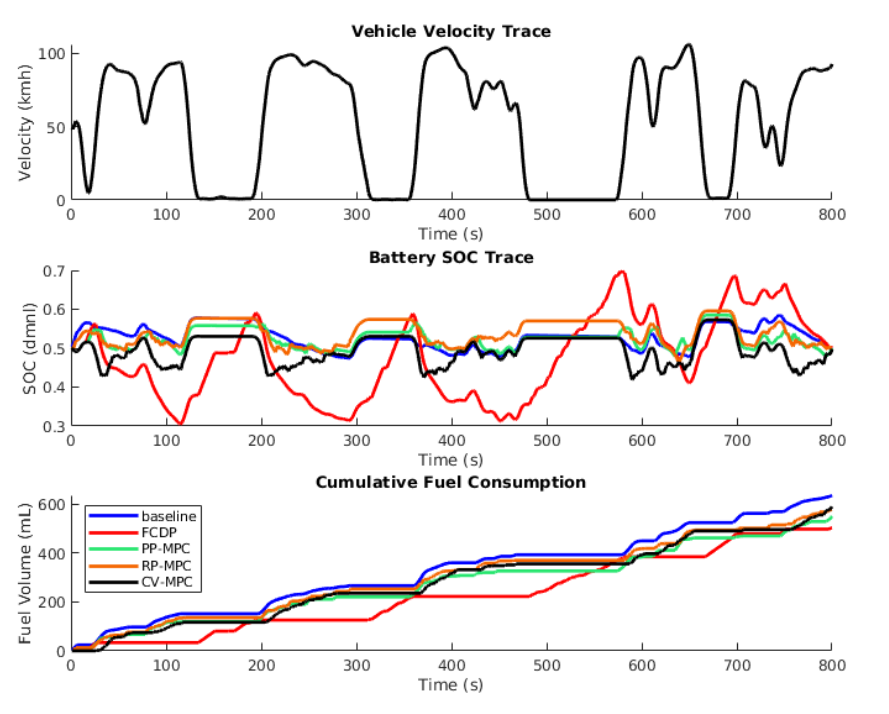
Figure 10. FE simulation data trace for all